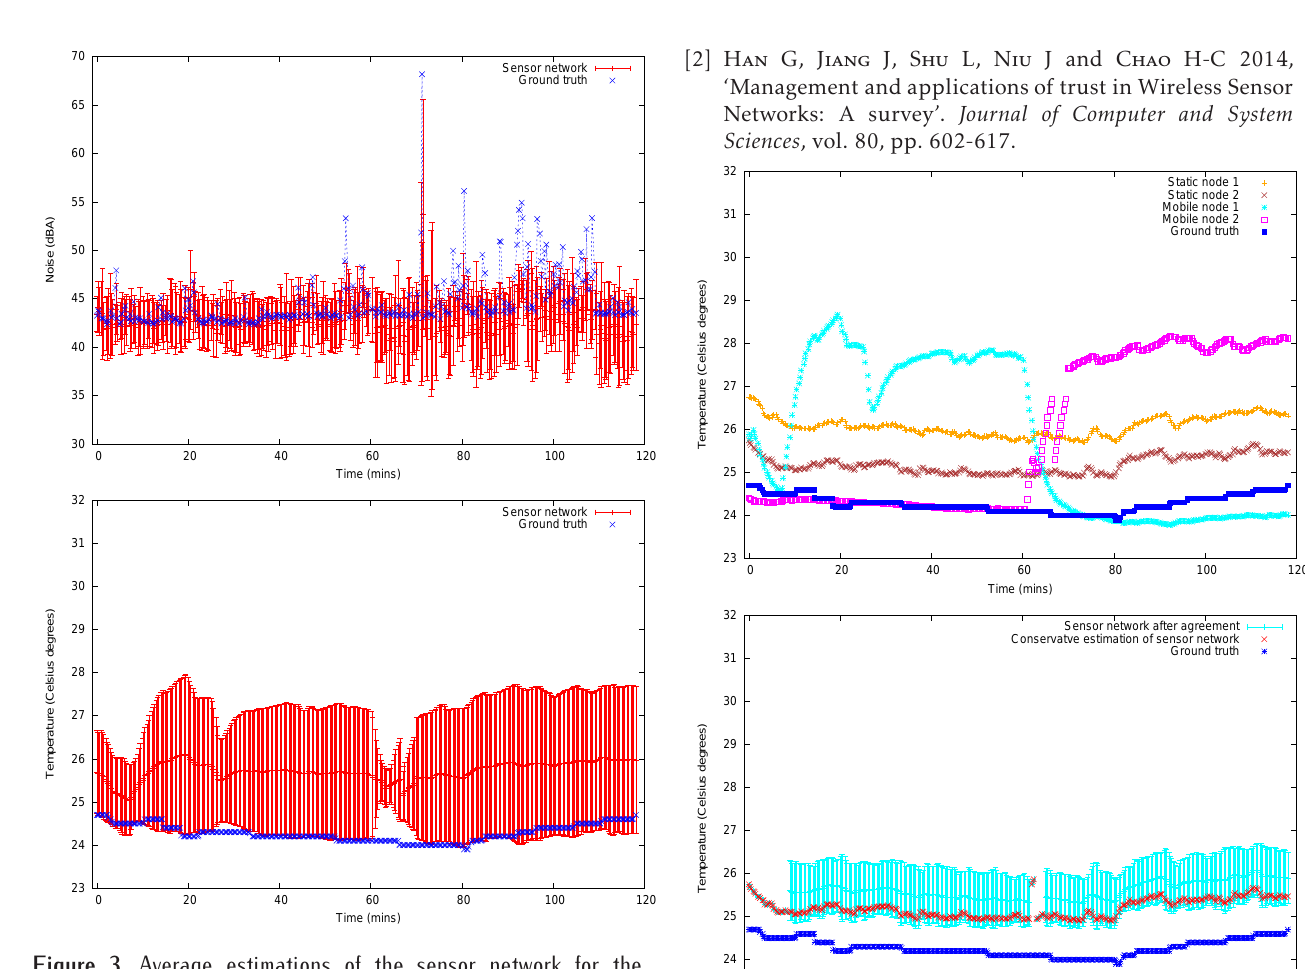
Figure 3. Average estimations of the sensor network for the parameters “noise” (top) and “temperature” (bottom), with respect to external references during 2 hours where mobile nodes were worn by a user